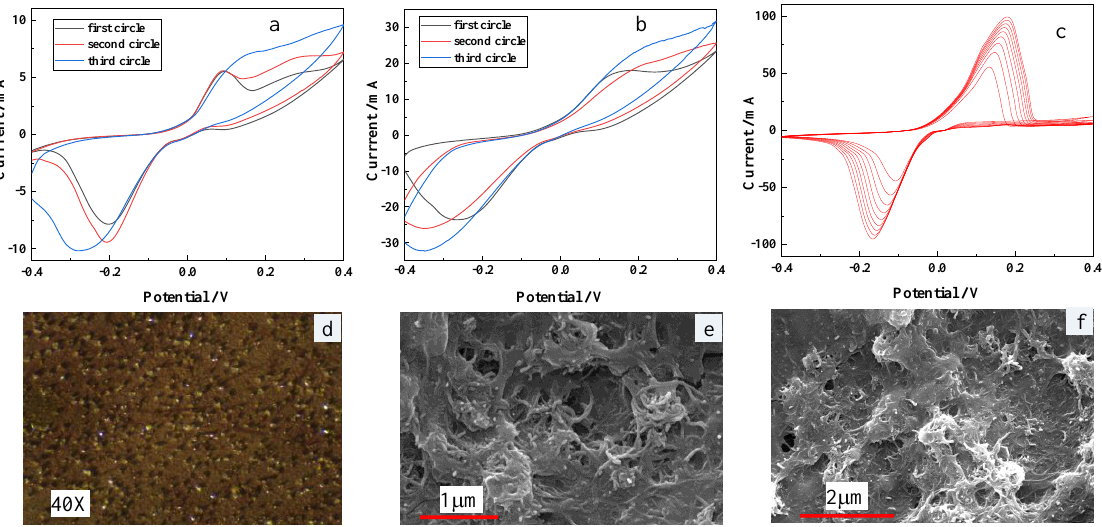
Figure 4. The results of the experiment. ( a ): CV curves of F-P film prepared by mixed electroplating. ( b ): CV curves of F-P film prepared by separate electroplating. ( c ): CV curves of F-P film prepared by electropolymerization. ( d ): micrograph of F-P film after electroplating. ( e , f ): SEM photographs of MWCNTs after dispersion.